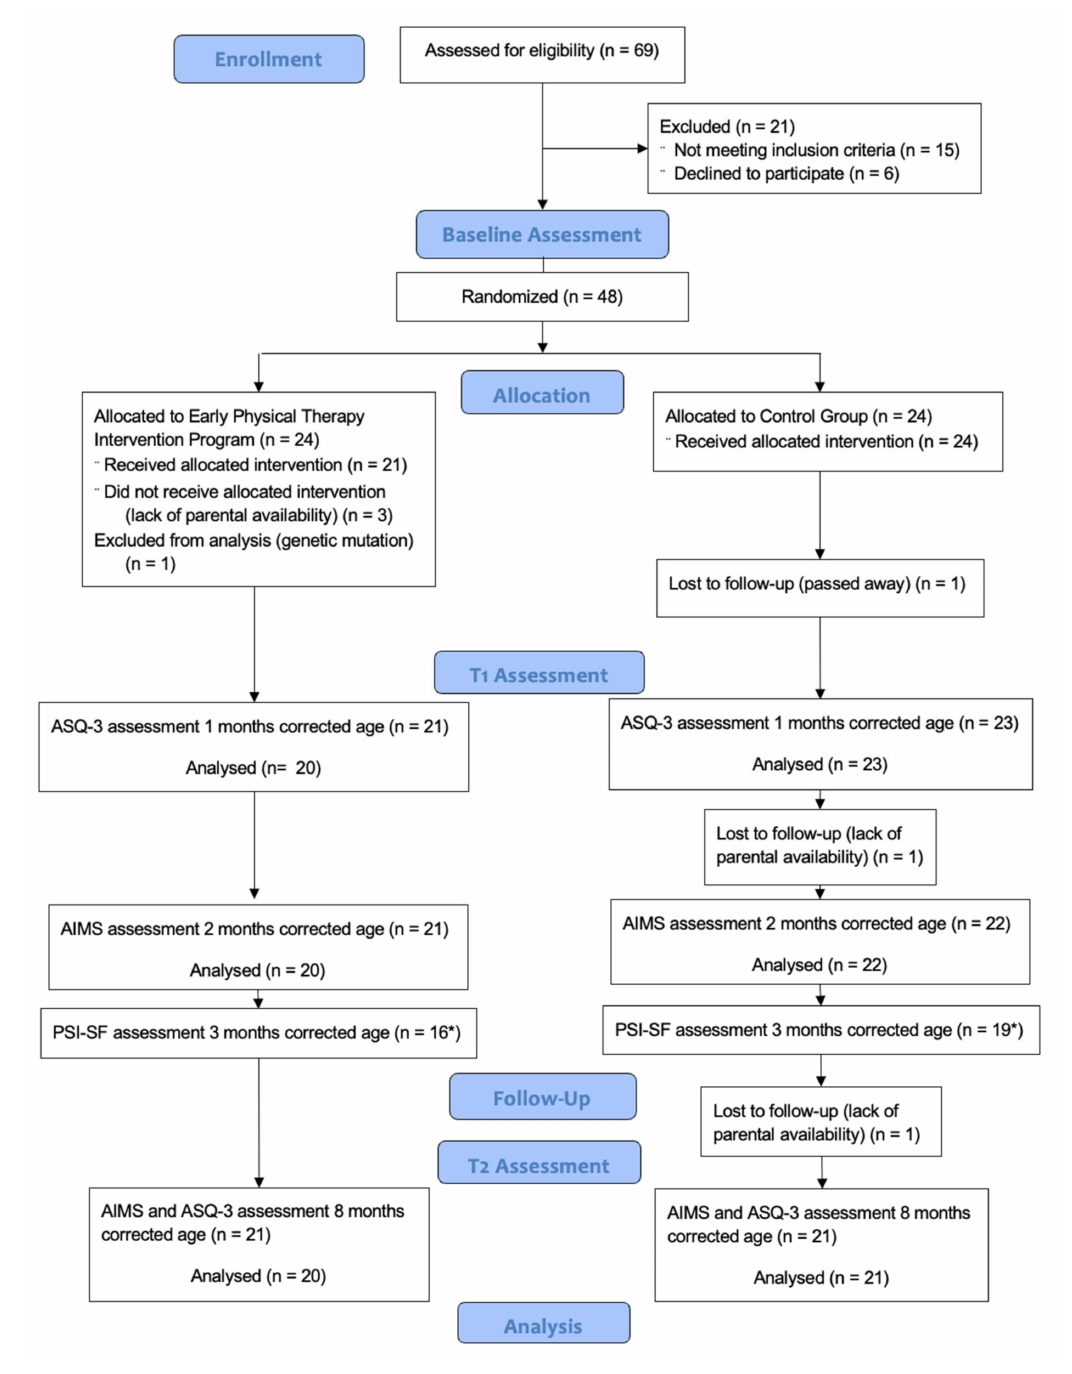
Figure 2. Flow-chart. * Mothers. Table 1. Sociodemographic and baseline characteristics of infants in the control group (CG), and intervention group